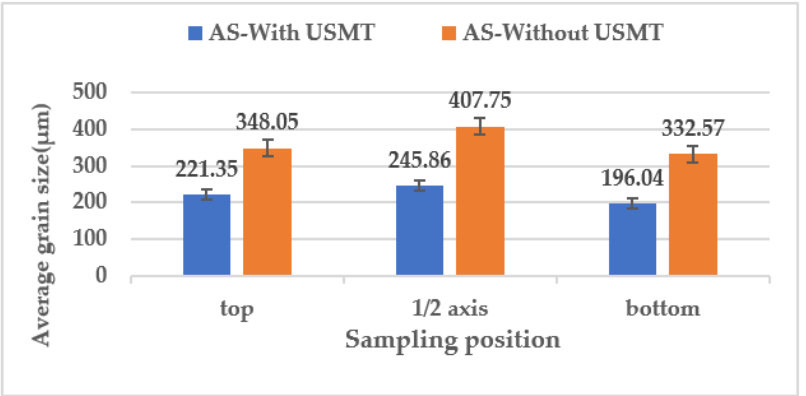
Figure 4. The grain sizes of the ingots with and without USMT at different sampling positions. Table 2. Average size (AS) and refining efficiency (RE) of the α -Al grain. Top Half Axis Bottom AS with USMT( µ m) 221.35 245.86 196.04 AS without USMT ( µ m)